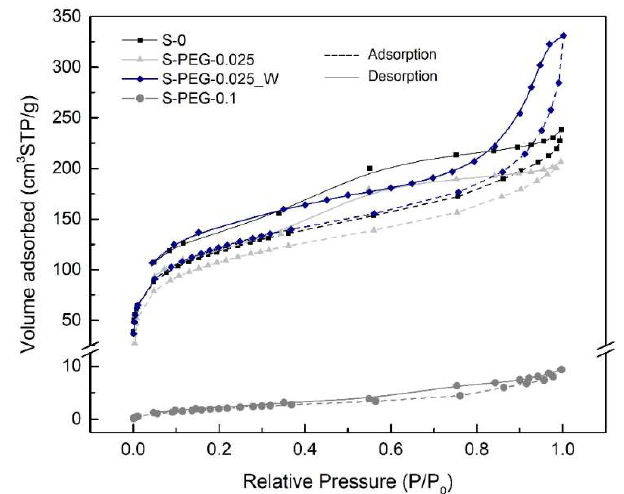
Figure 8. Nitrogen gas adsorption/desorption isotherms for aerogel-like materials with and without PEG additive.